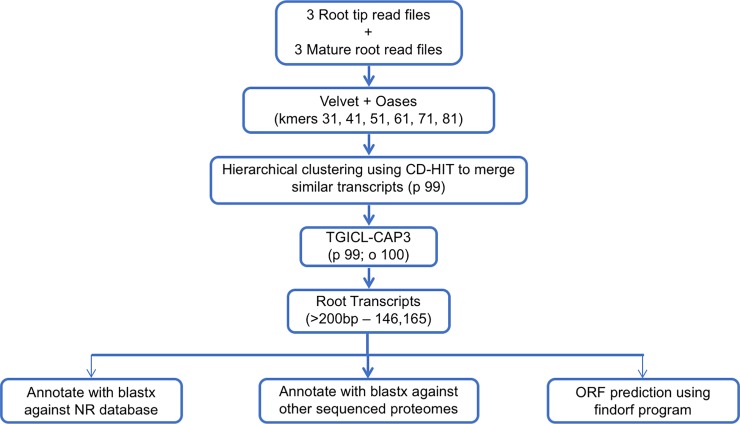
A flowchart of the assembly and annotation strategy for root transcriptome.Parameters for assemblies by Velvet/Oases, CD-HIT and TGICL-CAP3 are indicated in the parentheses.